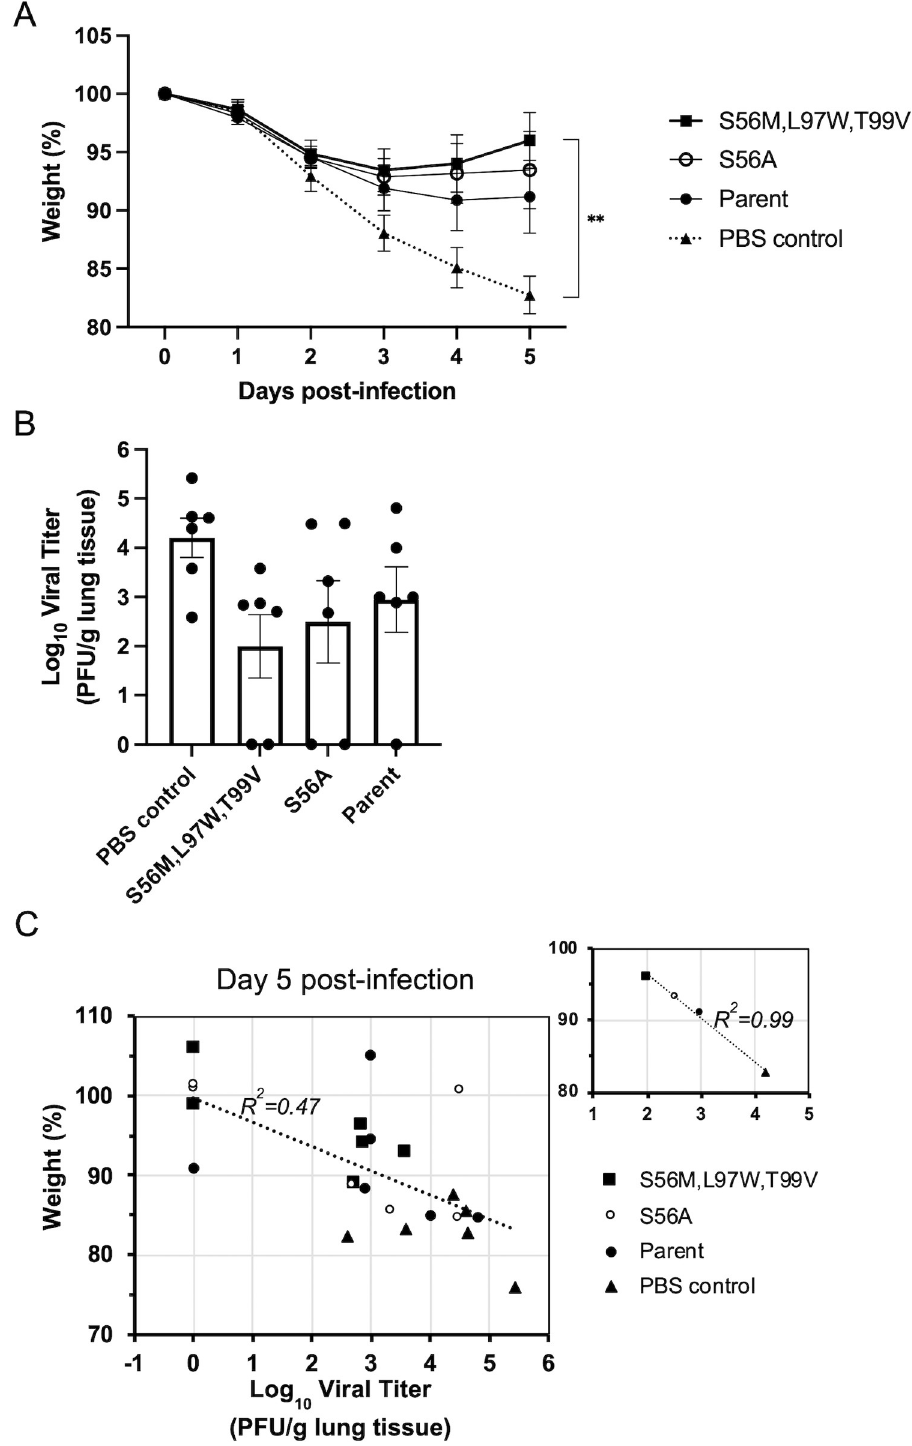
Fig 4. In vivo therapeutic efficacy of VHH-72-Fc lead mutant in SARS-CoV-2 infected hamsters. Male hamsters were challenged intranasally with 10 4 PFU of SARS-CoV-2 Wuhan isolate. Four hours later they were administered test articles intraperitoneally at a dose of 10 mg/kg. Each group consisted of 6 animals. ( A ) Body weight measurements during the time course of the experiment (Mean +/- SEM). ( B ) Live virus titers in lung tissues at day 5 post-infection determined with the plaque assay (Mean +/- SEM). ( C ) Correlation between body weight measured at day 5 post-